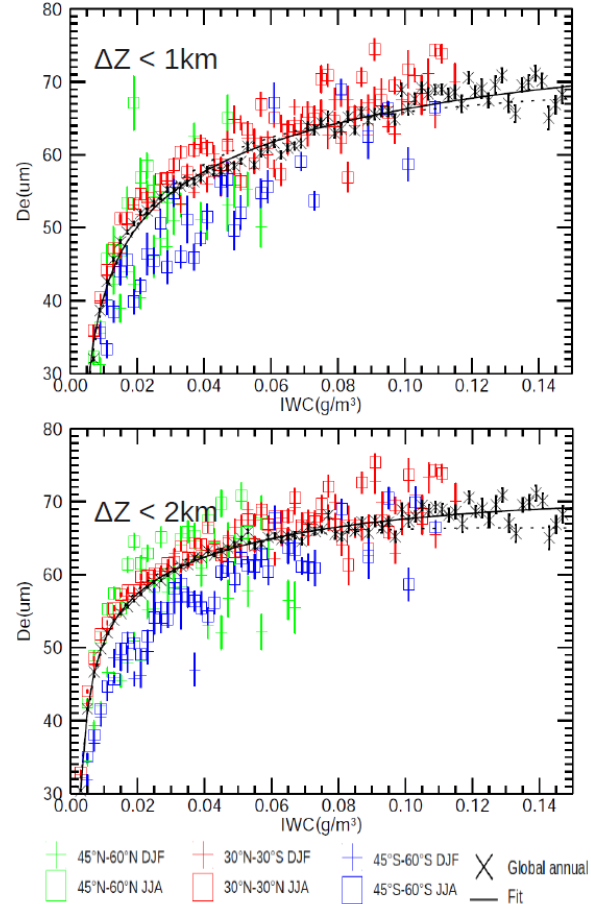
Fig. 16. Relationship between D e and an estimation of the average IWC for ST-HICs with vertical extent between 0.5 and 1 km (top) and between 0.5 and 2 km (bottom). Results are shown for three latitude bands in boreal summer and in boreal winter. The global annual dependence is also shown (black cross), as well as the parameterization of Eq. 5 (black line). For comparison is shown parameterization developped in McFarquhar et al. (2003) (black dashed lines). Statistics is over the period 2007 - 2008.